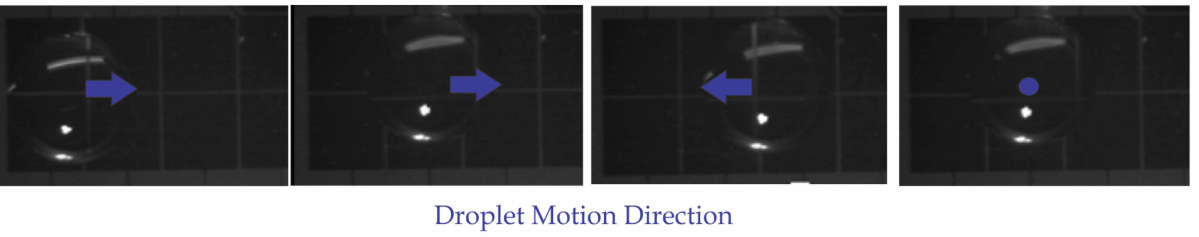
Figure 9. The smartphone controls a preprogrammed droplet motion on top of a DMF chip.